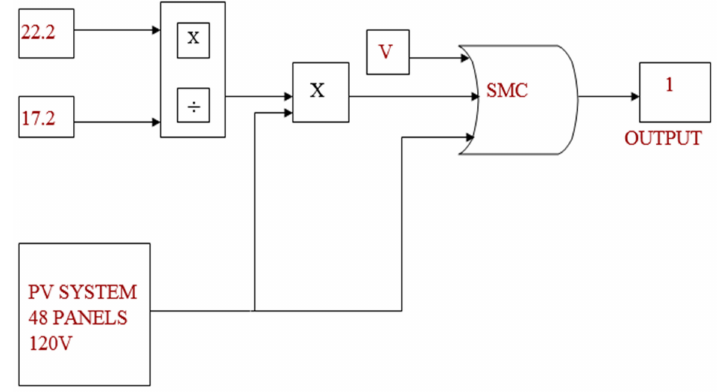
Figure 6. Mode controller in MATLAB Simulink